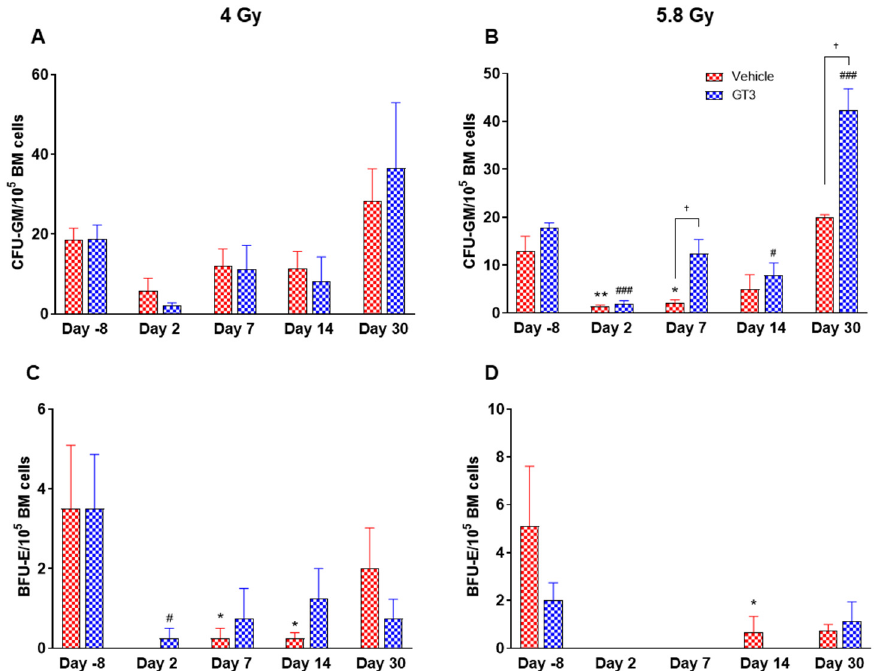
Figure 11. Effects of 4 and 5.8 Gy on CFU-GM ( A , B ) and BFU-E ( C , D ) counts post 14-day culture. NHPs received GT3 (37.5 mg/kg) or vehicle 24 h prior to irradiation (4 and 5.8 Gy). BM cells were collected at various time points and clonogenic function of HSCs were measured by CFU assay for colony forming unit-granulocyte macrophage (CFU-GM) ( A , B ), and burst-forming unit-erythroid (BFU-E) ( C , D ). Data are shown as the mean ± SEM. * p < 0.05, ** p < 0.01 vs. vehicle day-8; # p < 0.05, ### p < 0.001vs. GT3 day-8. † p < 0.05, Vehicle vs. GT3.